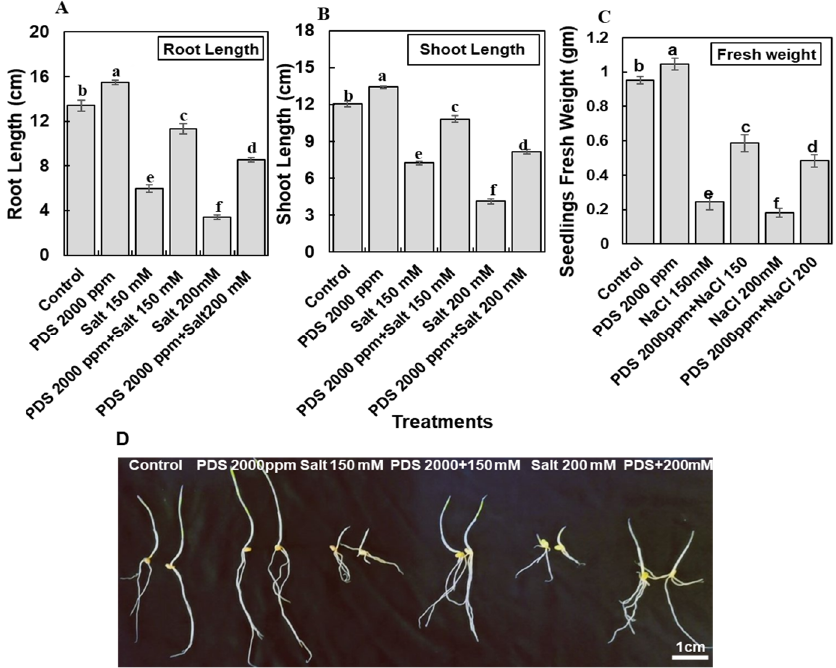
Figure 3. Effect of PDS on root and shoot length of wheat under normal and salt stress. Seedling growth was observed under control, PDS 2000 ppm, salt 150 mM and 200 mM, and PDS 2000 ppm + salt 150 or 200 mM treatment. ( A ) Length of root was observed at day 7 after protruding of the radical. Root length was measured by randomly selecting 10 plants from each treatment. The x -axis represents different treatments. ( B ) Shoot length was measured at day 7 by randomly selecting 10 seedlings from each treatment. ( C ) Fresh weight was quantified when the morphological changes were clearly visible (day 7), the fresh weight (g) of the 10 plants from each treatment was assessed. Three different batches of trials yielded the mean values and standard error (bars on graph). ( D ) Photographs were taken at day 7. White line represents the scale bar (1 cm). All data were analyzed using one-way ANOVA, with multiple comparisons using LSD test at a significance threshold of p ≤ 0.05 ( n = 10). The different lowercase alphabets represent homogeneous subsets and it’s indicates the statistical significantly according to Fisher LSD at level p <